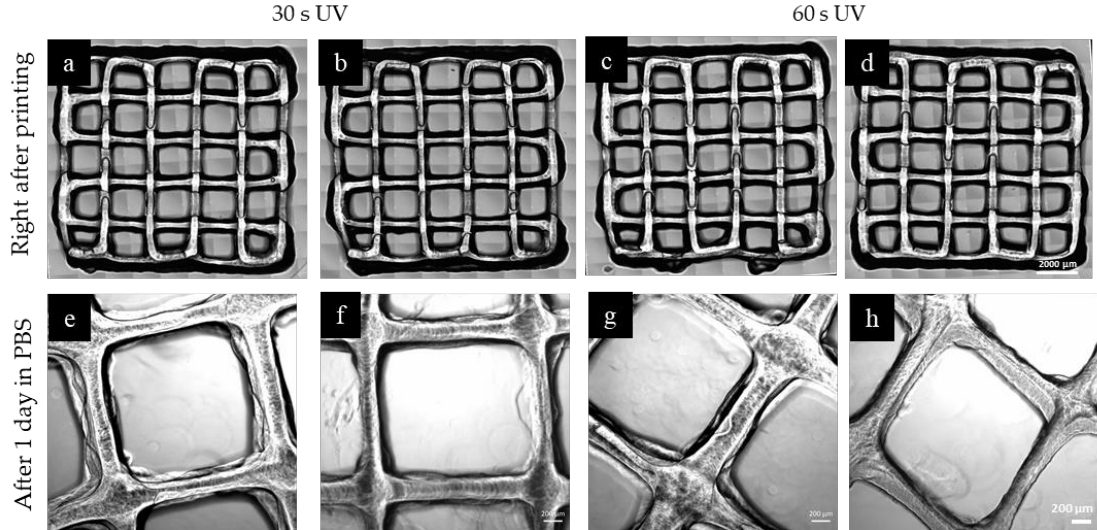
Figure 6. 3D printed constructs made of 6 layers, prepared using ( a , b , e ) 30 s of UV crosslinking without mTGase treatment, ( f ) 30 s of UV crosslinking with 30 min mTGase treatment, ( c , d , g ) 60 of s UV crosslinking without mTGase treatment, ( h ) 60 s of UV crosslinking with 30 min mTGase treatment. (Scale shows 2000 µ m for upper row and 200 µ m for lower